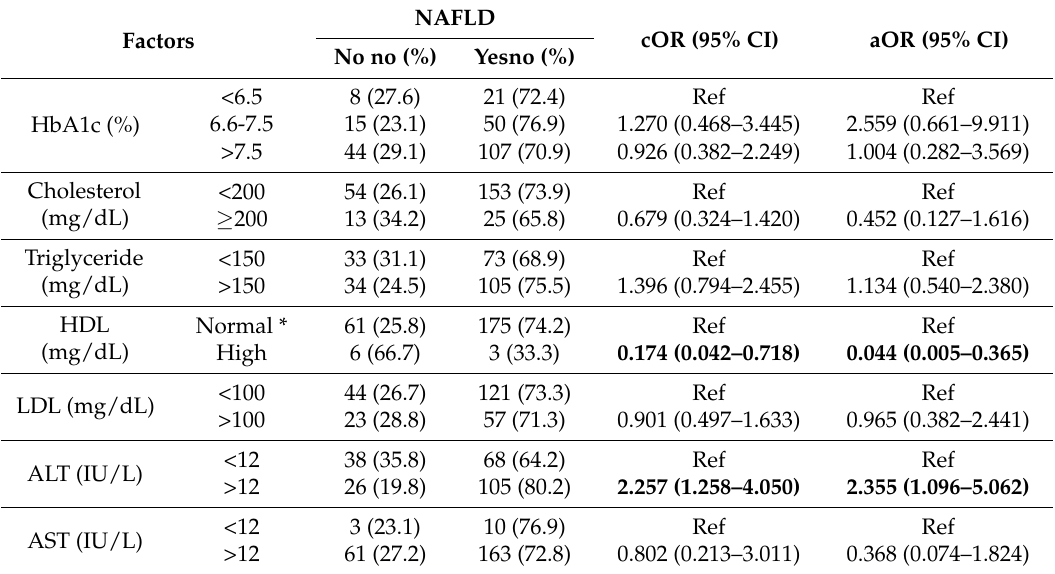
Table 2. Biochemical Factors associated with NAFLD among the study sample of T2DM patients ( n =